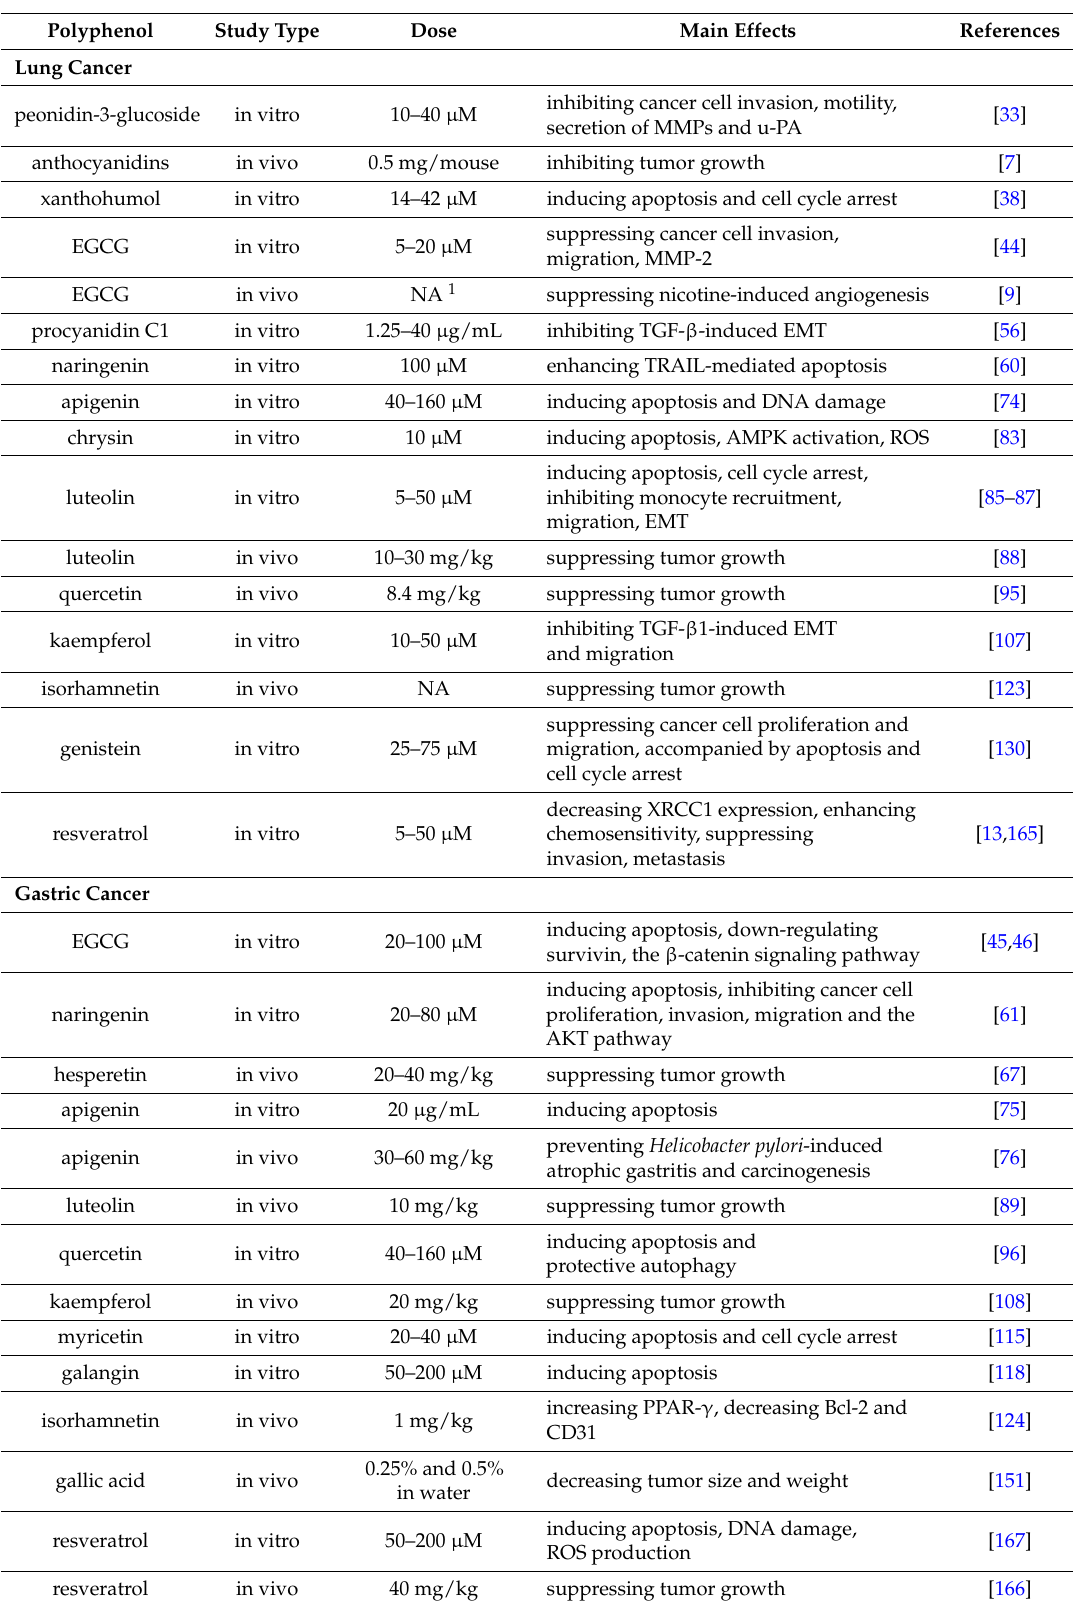
Table 3. The in vitro and in vivo anticancer activities of natural polyphenols. Polyphenol Study Type